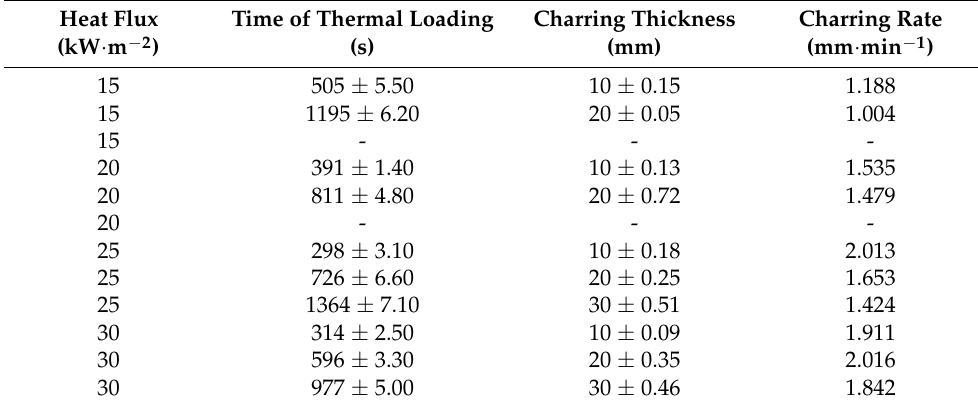
Table 2. Thickness and charring rate of test samples. The values are the mean ± the